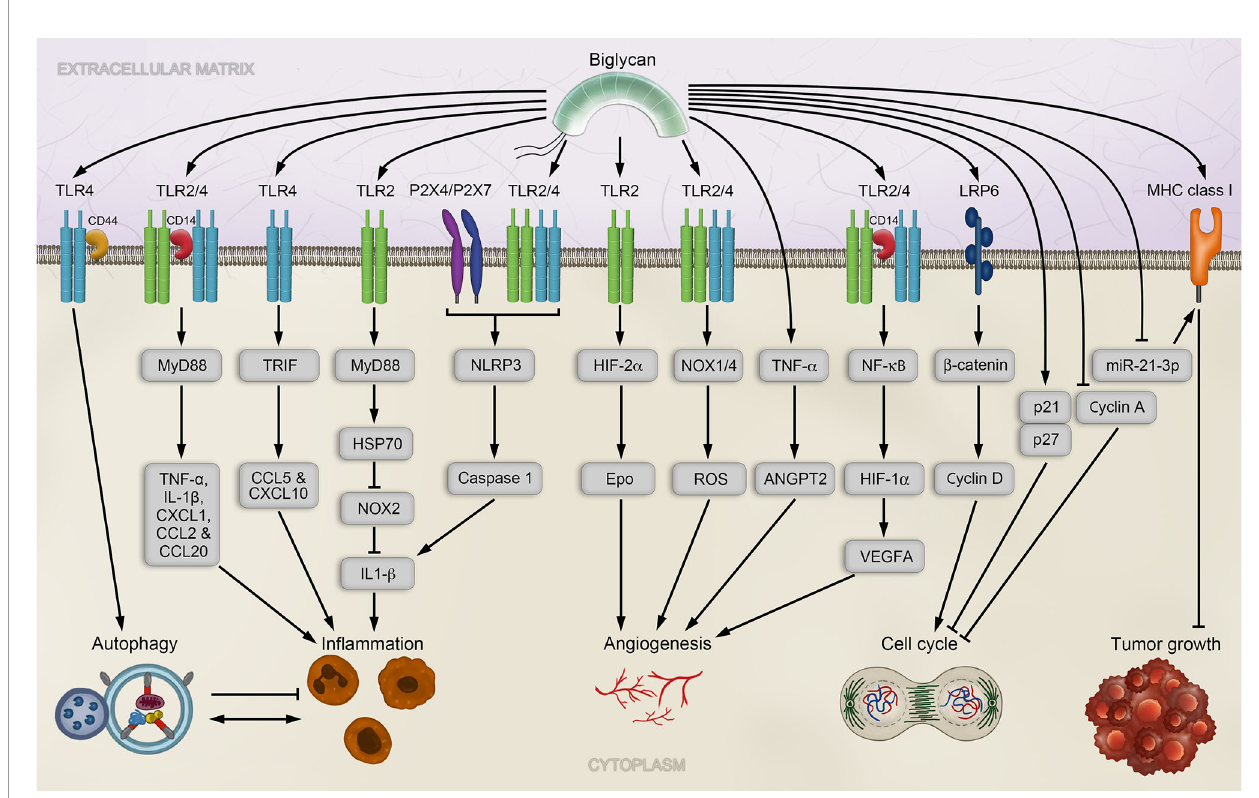
FIGURE 2 | Biglycan signaling and implications in tumorigenesis. Soluble biglycan induces TLR4/CD44mediated autophagy in macrophages and TLR2/4/CD14- mediated in fl ammation via the adaptor molecule MyD88. In fl ammation is also trigger by biglycan binding to TLR4 via TRIF, or TLR 2 via MyD88. Biglycan-mediated clustering of TLR2/4 with the P2X4/P2X7 receptors, which activates the NLRP3 in fl ammasome, consequently leading to the maturation of IL-1 b . In endothelial cells, biglycan promotes angiogenesis in a TLR2/4-dependent manner by enhancing HIF-1 a activity and VEGFA expression. Biglycan further affects ROS production via TLR2 and TLR4 in a NOX1- and NOX4-dependent manner. Biglycan stabilizes HIF-2 a via TLR2 interaction and leads to of Epo synthesis. Biglycan knockout impaired tumor by repressing TNF- a and ANGPT2 signaling in a cancer mouse model. Additionally, biglycan can induces a cell cycle arrest by increasing the expression p27 and p21 and decreasing Cyclin A levels. By increasing MHC complex I expression via miR-21-3p, biglycan exerts anti-tumoral activities.ANGPT2, angiopoietin 2; CCL, chemokine C – C motif-ligand; CD, cluster of differentiation; CXCL, chemokine C-X-C motif-ligand; Epo, erythropoietin; HIF-1/2 a , hypoxia- inducible factor 1/2 a ; HSP70, heat shock protein 70; IL-1 b , interleukin 1 beta; LRP6, low-density lipoprotein receptor-related protein 6; MHC, major histocompatibility complex; miR, microRNA; MyD88, myeloid differentiation primary response 88; NF- k B, nuclear factor kappa-light-chain-enhancer of activated B- cells; NLRP3, NOD-like receptor protein 3; NOX, NADPH oxidase; ROS, reactive oxygen species; TLR2/4, Toll-like receptor 2/4; TNF- a , tumor necrosis factor alpha; TRIF, TIR-domain-containing adapter-inducing interferon- b ; VEGFA, vascular endothelial growth factor